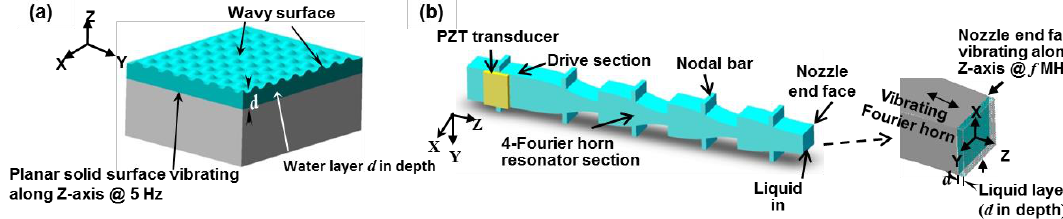
Figure 2. ( a ) Classical planar geometry for Faraday wave formation at low drive frequency; ( b ) 3-D architecture of MHz 4-Fourier horn ultrasonic nozzle depicting the geometry of its end face and the liquid layer.